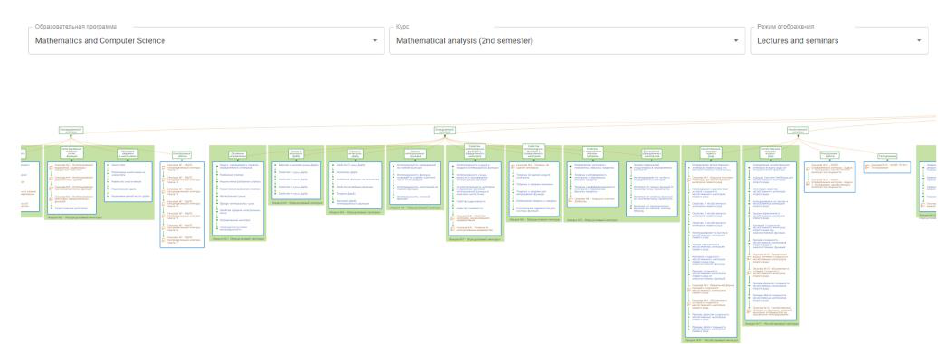
Fig. 1. The structure of the course "Mathematical analysis (2nd semester)" in the DLS